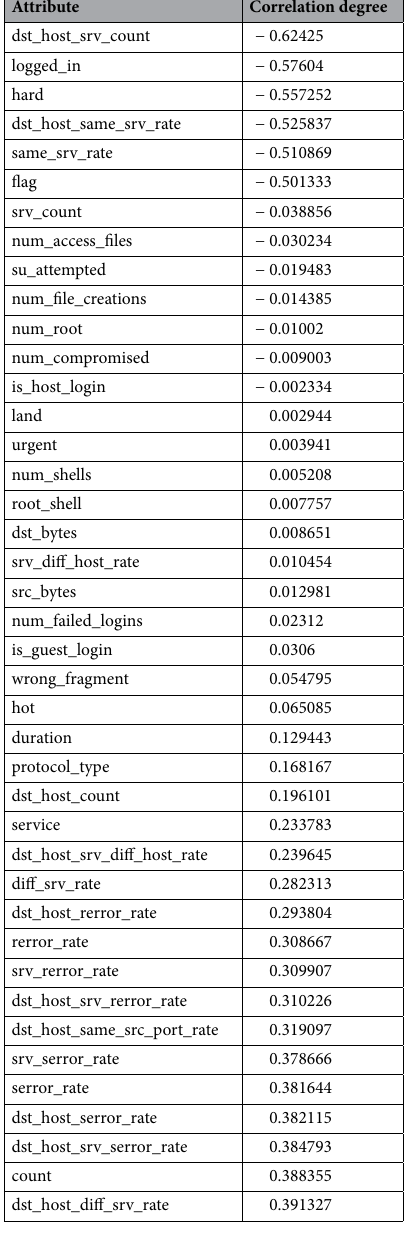
Table 3. Correlation degree of 41 attributes towards